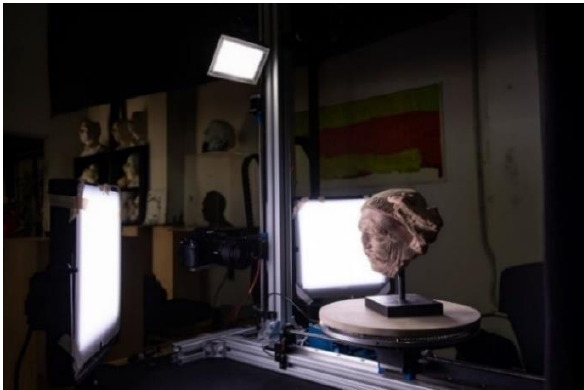
Figure 1. Small object